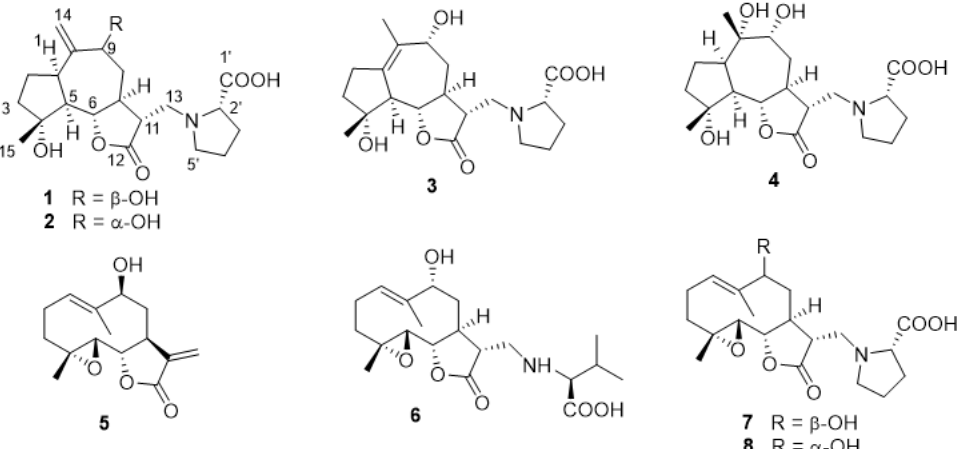
Figure 1. The sesquiterpenoid derivatives isolated from A. garcinii .